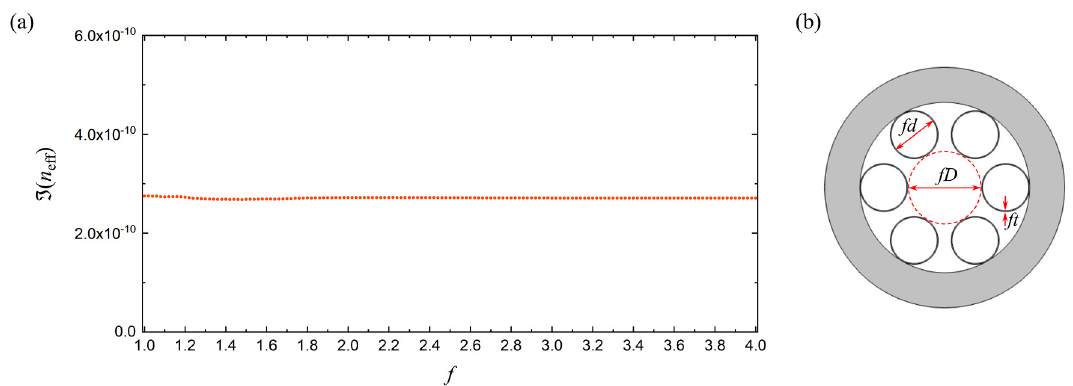
Figure 2. ( a ) Imaginary part of effective index of the fundamental core mode, ℑ(cid:4666)𝑛 eff (cid:4667) , in a six-tube THCF versus f when the fiber structure depicted in ( b ) and wavelength are both scaled by f . The parameters used in the calculation are λ = 1.06 µm, D = 26.5 µm, d = 17.2 µm, and t = 0.26 µm.